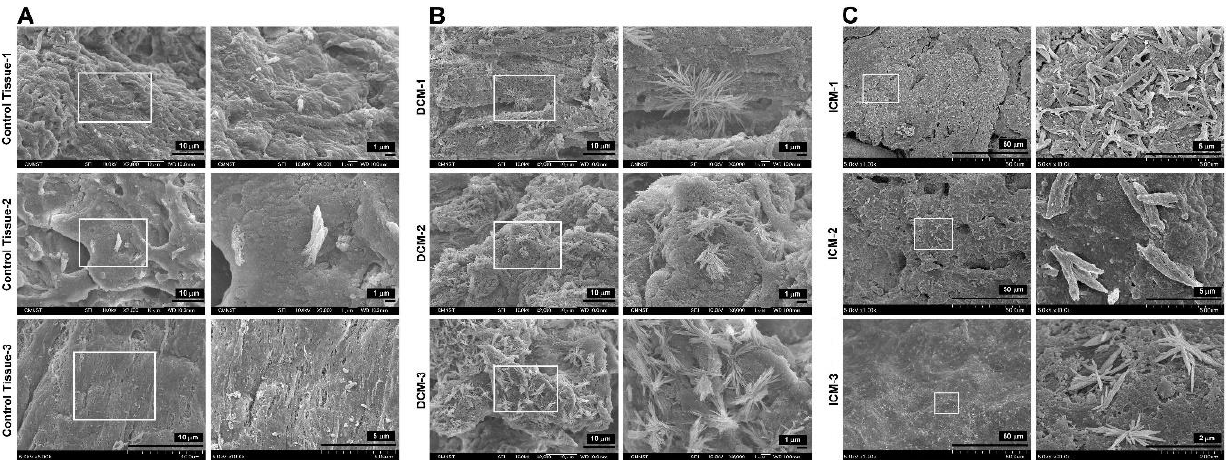
Figure 5. Mineral deposition in healthy subjects and patients with DCM and ICM. ( A ) Depositions in the right auricle endocardium from coronary artery bypass graft (CABG) surgery patients (non-HF). ( B ) Depositions in the endocardium of patients with DCM. ( C ) Depositions in the endocardium of patients with ICM.